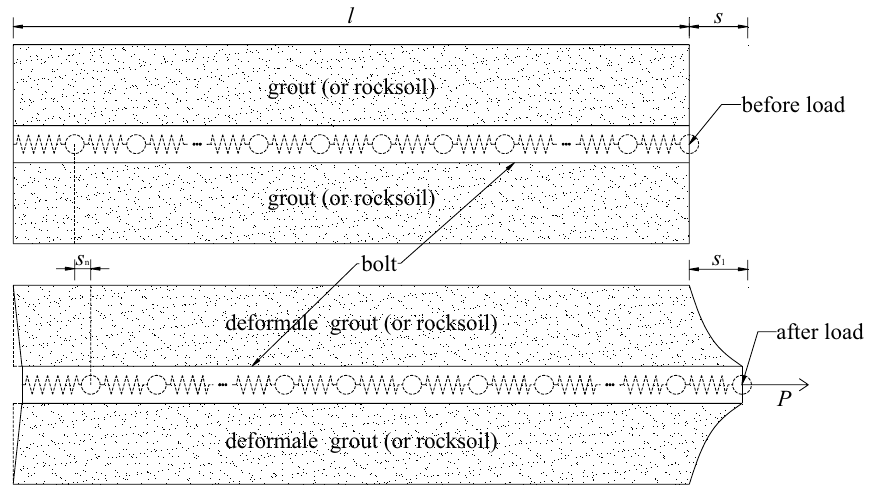
Figure 2. Discretization schematic diagram of bolt.